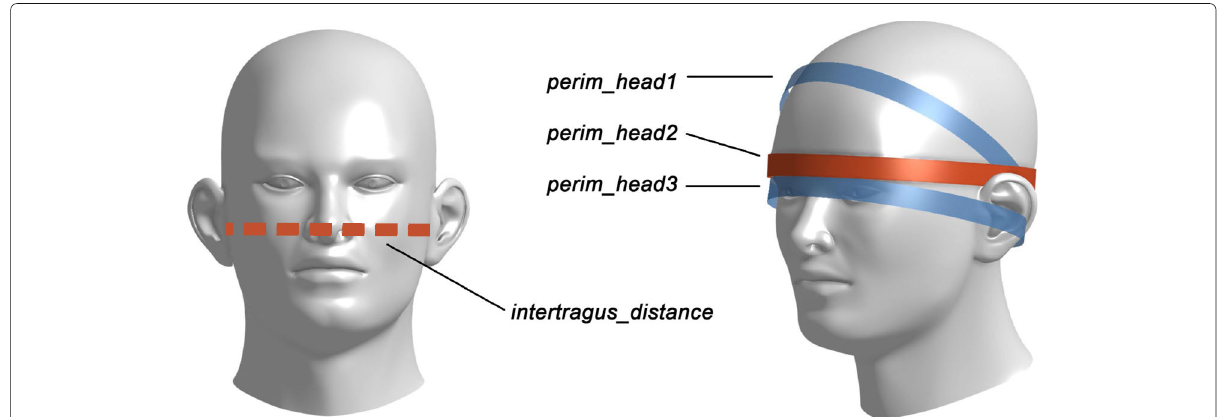
Fig. 2 Anthropometric measurements performed on the subjects: intertragus_distance , perim_head1 , perim_head2 , and perim_head3